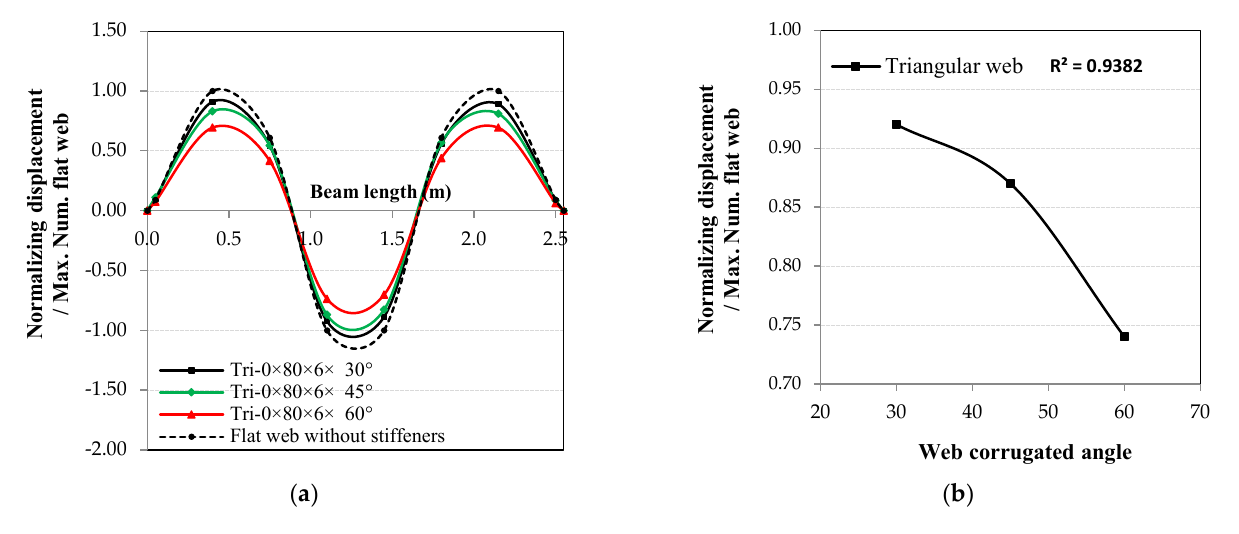
Figure 20. Corrugated angle effect on the relationship between normalized displacement and beam length for the 3rd mode shape: ( a ) triangular web and ( b ) angle effect at the 3rd mode shape.